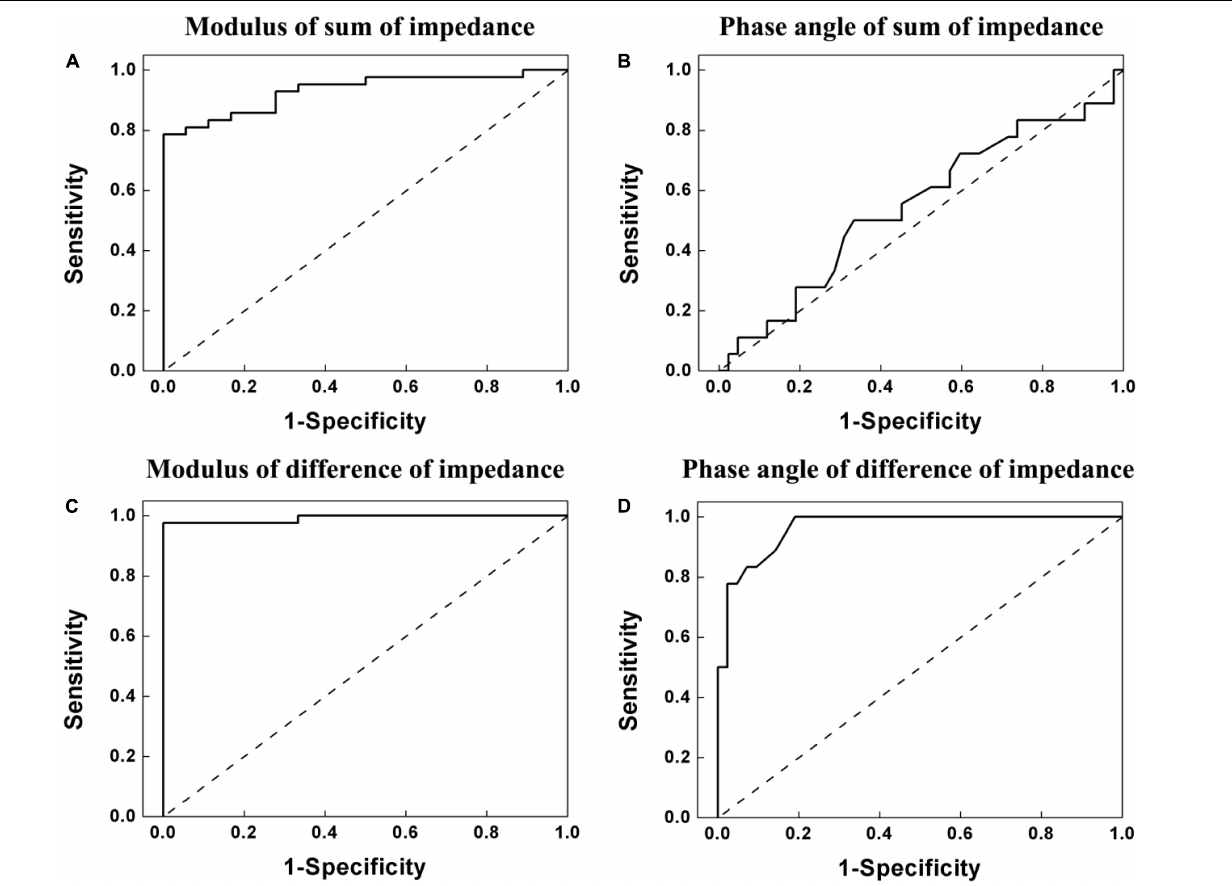
FIGURE 8 | Receiver operating characteristic (ROC) curve of the lumbar muscle impedance for ability to predict pain (Scale 2, 3, and 4 in ODI). (A) Modulus of sum of lumbar muscle impedance on both sides. (B) Phase angle of sum of lumbar muscle impedance on both sides. (C) Modulus of difference of lumbar muscle impedance on both sides. (D) Phase angle of difference of lumbar muscle impedance on both sides. For modulus ( Z sum ) and phase angle ( φ sum ) of sum of lumbar muscle impedance on both sides, as well as modulus ( Z diff ) and phase angle ( φ diff ) of difference of lumbar muscle impedance on both sides, the areas under the ROC curve (AUC) of the, the were 0.931, 0.548, 0.992, and 0.965, respectively, for pain prediction (LBP Scale 2, 3, and 4). The sensitivity and specificity range from 0.501 to 0.976 and from 0.667 to 1,